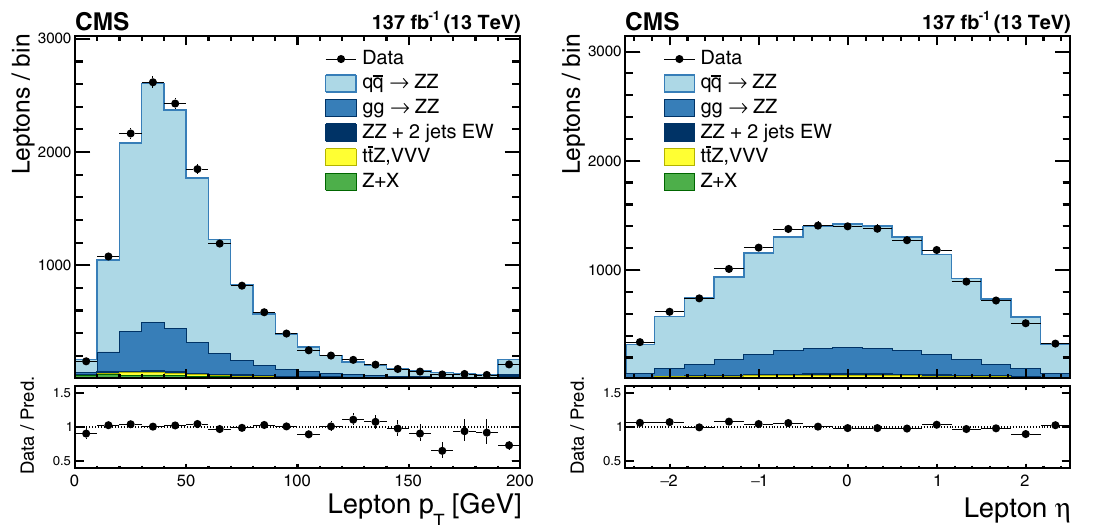
Fig. 1 Distributions of (left) transverse momentum and (right) pseu- dorapidity for individual leptons. Points represent the data with error bars showing the statistical uncertainties, histograms the expected SM